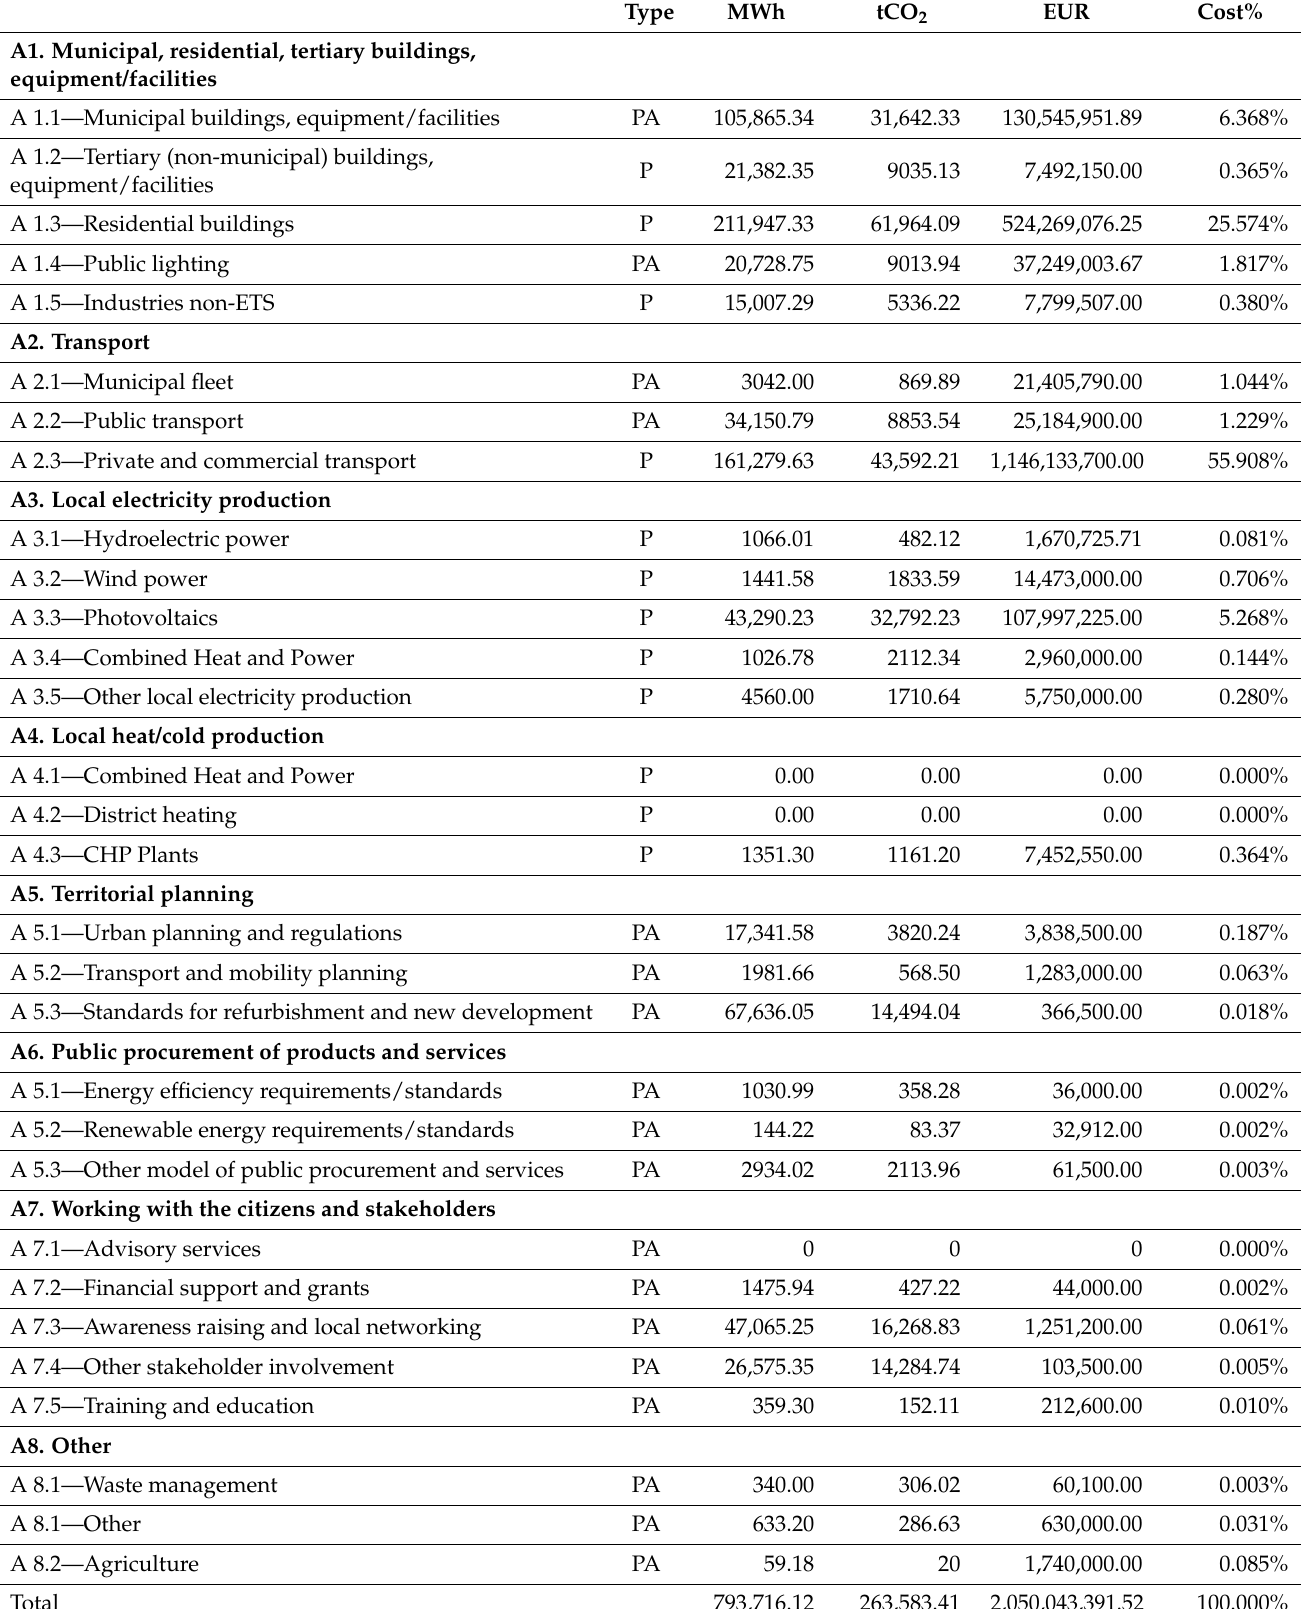
Table 8. Resource allocation SEAP